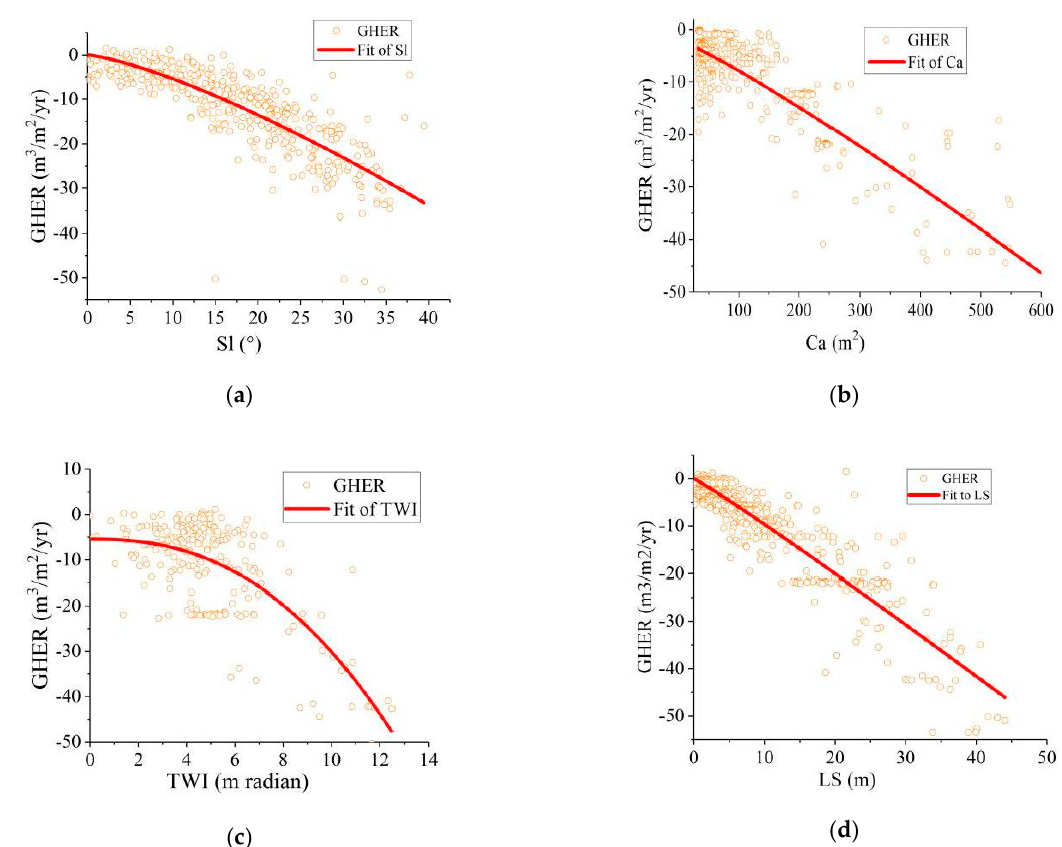
Figure 15. Polynomial regression function fitting curves of ( a ) Sl, ( b ) Ca, and ( c ) TWI, ( d ) LS,